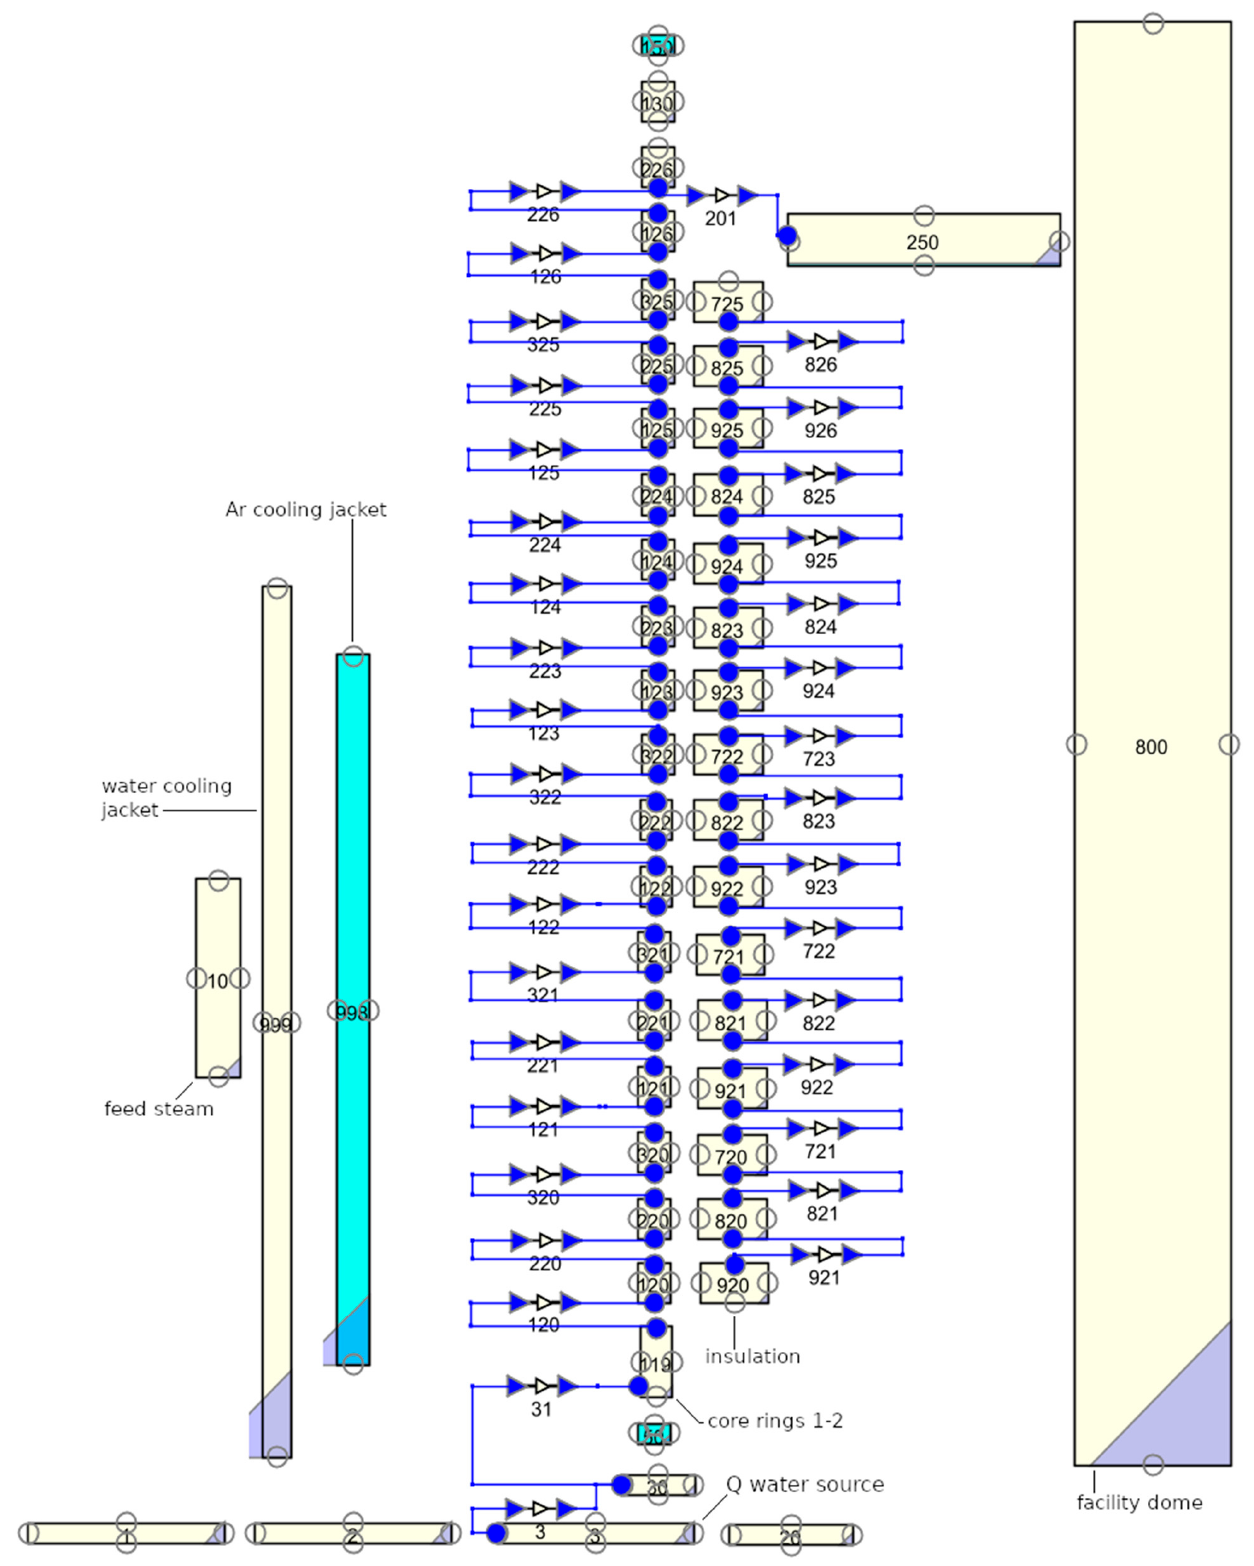
Figure 3. Model nodalization: control volumes and flow junctions.